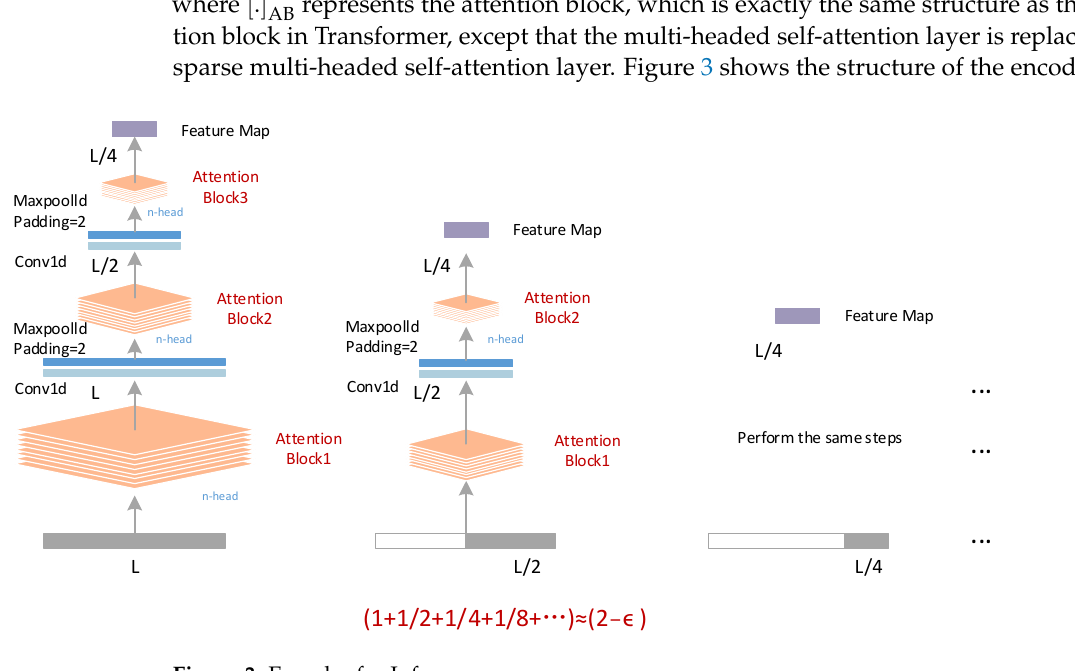
Figure 3. Encoder for Informer.